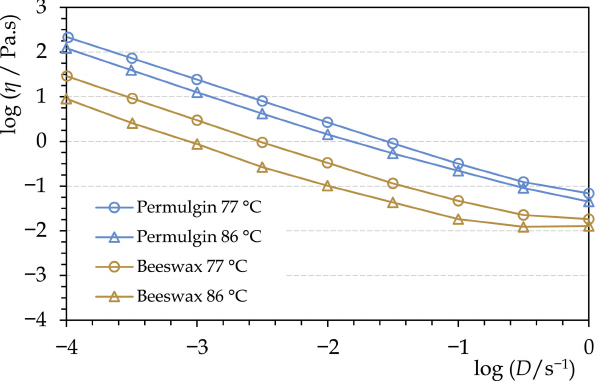
Figure 6. Comparison of rheograms of beeswax and Permulgin 3274 for two temperatures, below and above the drop point of Permulgin